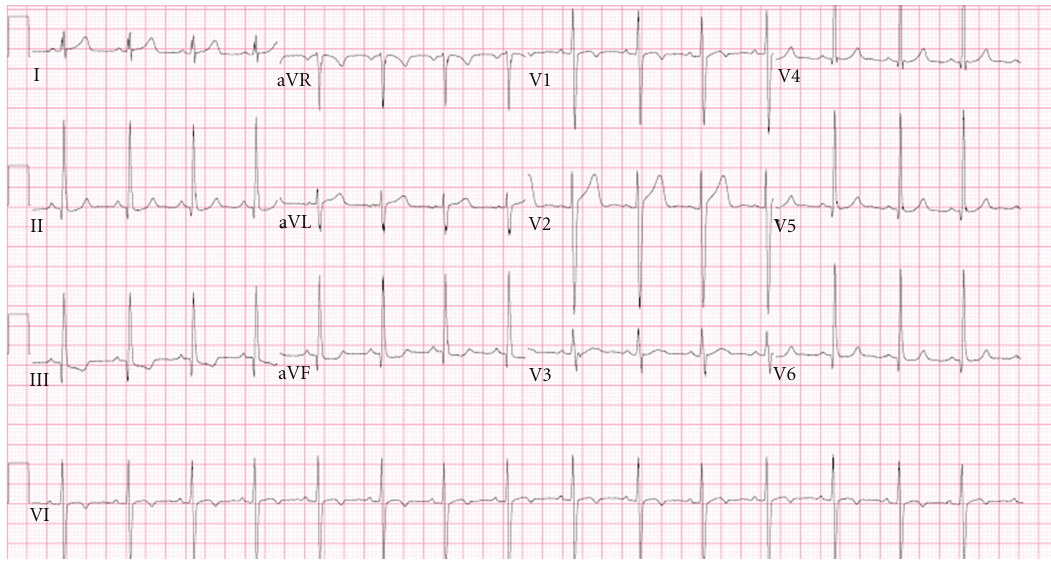
Figure 4: Electrocardiogram 6 hours o ff Asacol: normal sinus rhythm and nonspecific ST changes.